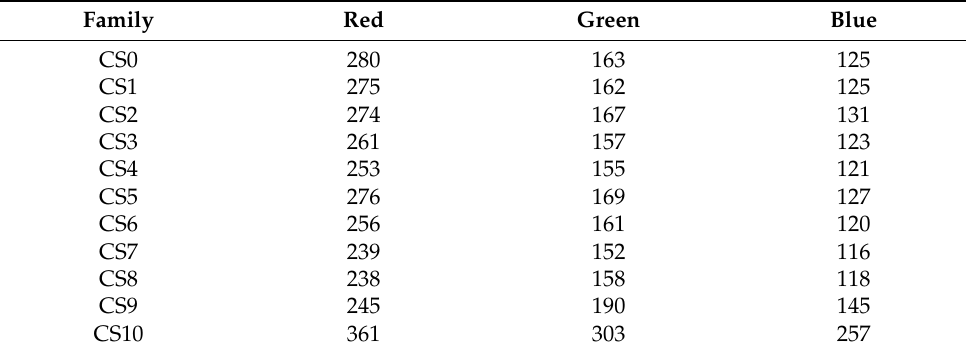
Table 7. Color coordinates (Red, Green and Blue) of the different families of ceramics. Family